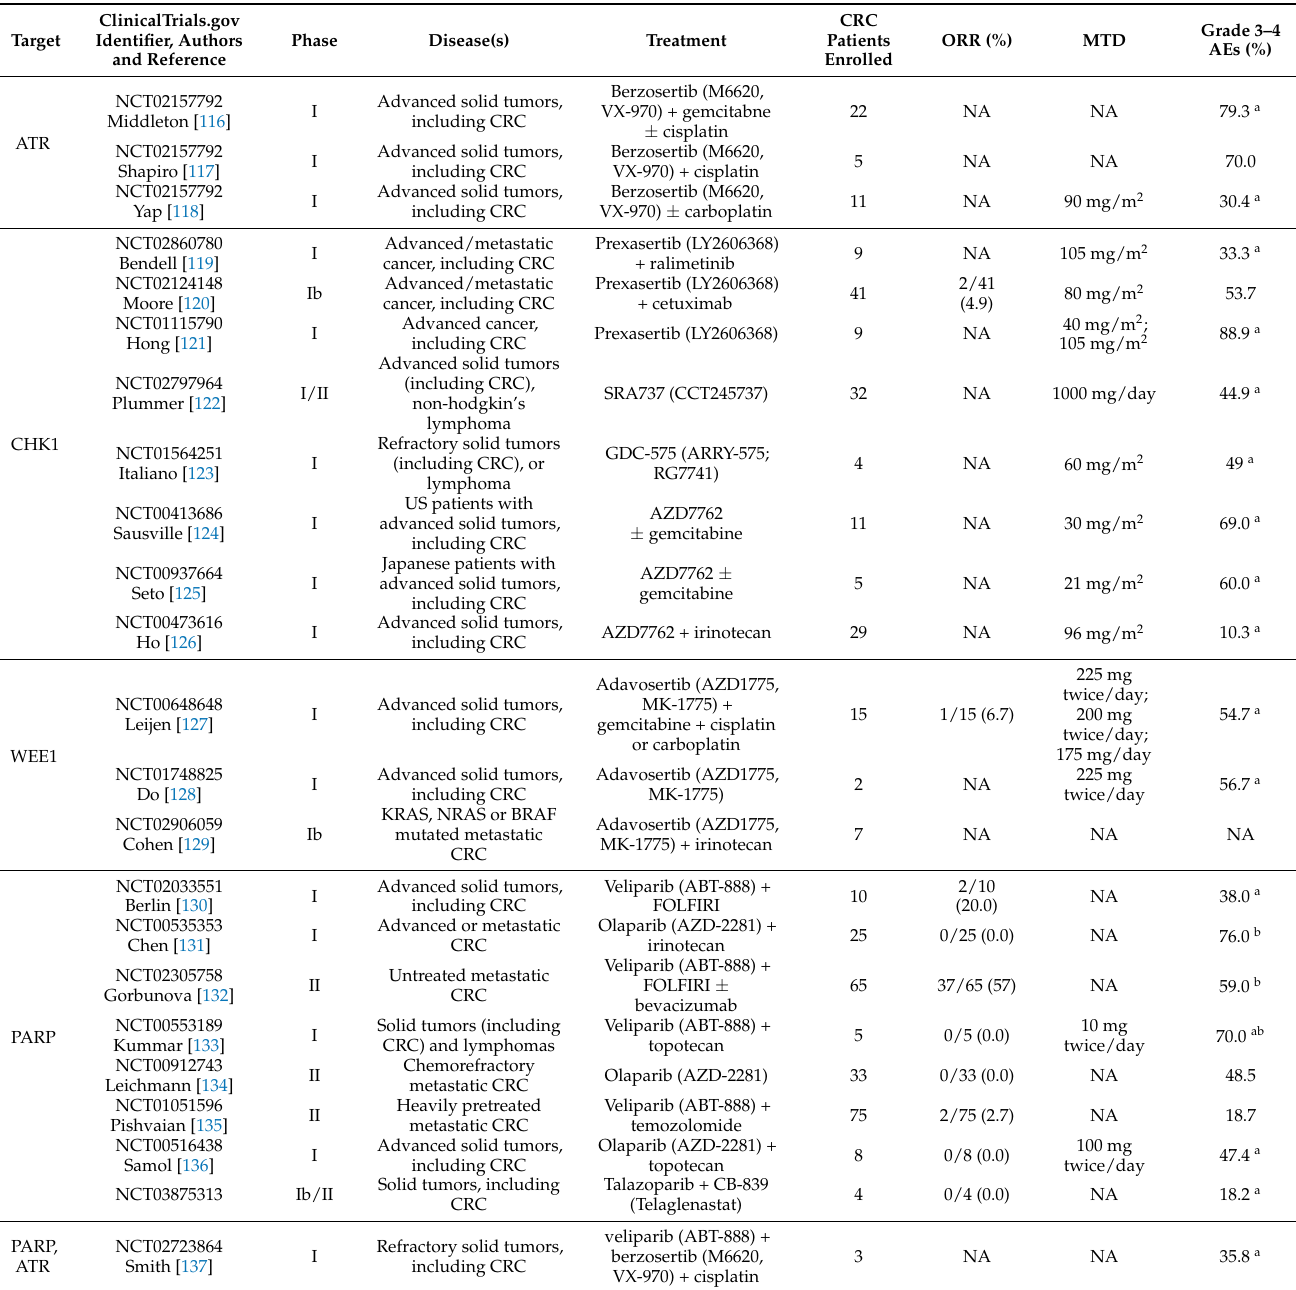
Table 2. Completed clinical trials investigating the potential role of DDR and DNA repair pathways inhibitors as monotherapy or combined with chemotherapy in